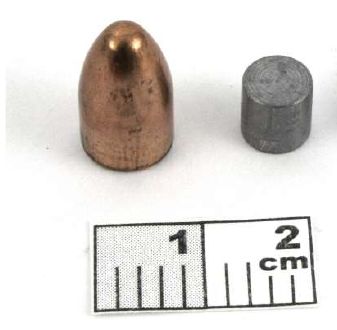
Figure 3. Picture of the specimen extracted from the ammunition.